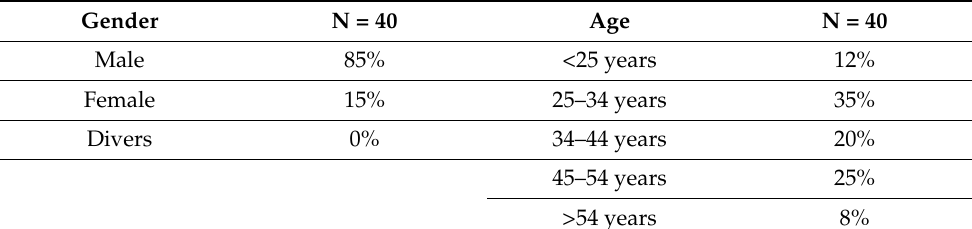
Table 4. Analysis of persona development data.—Gender and Age.